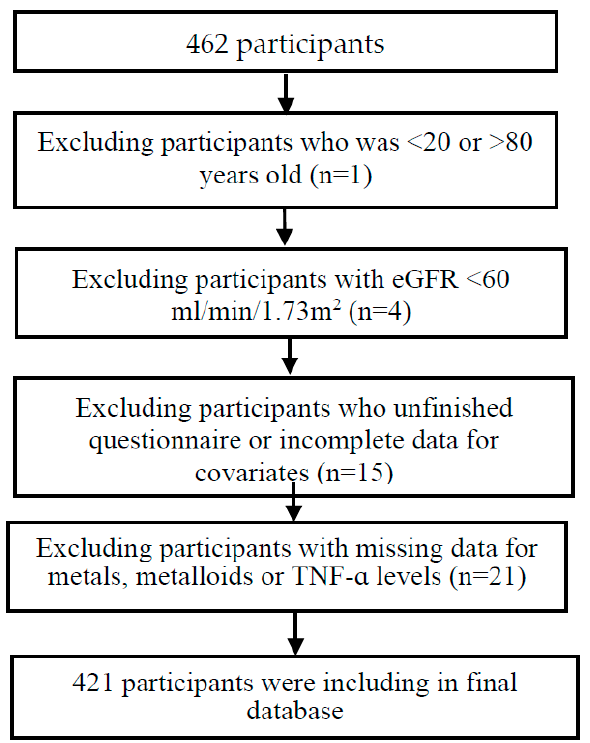
Figure 1. The number of the participants changes in the study.